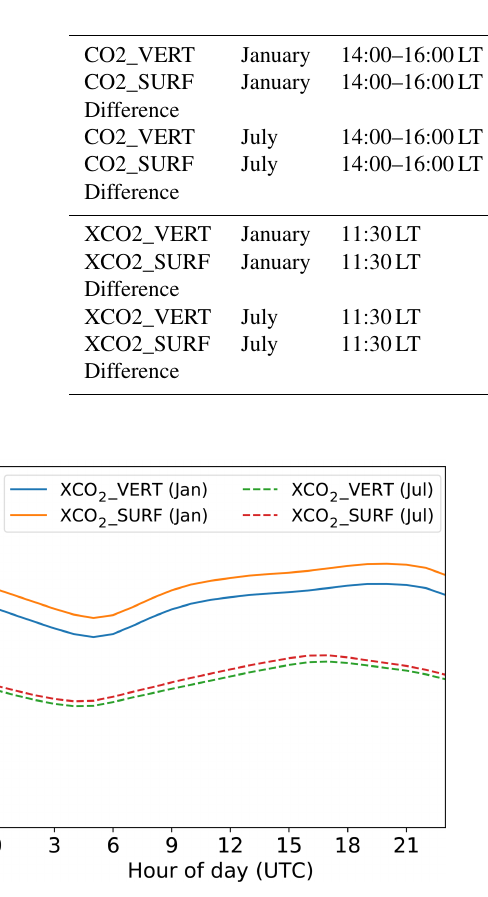
Figure 11. Mean diurnal cycles of column-averaged dry air mole fractions (XCO 2 ) of the tracers CO2_VERT and CO2_SURF in January and